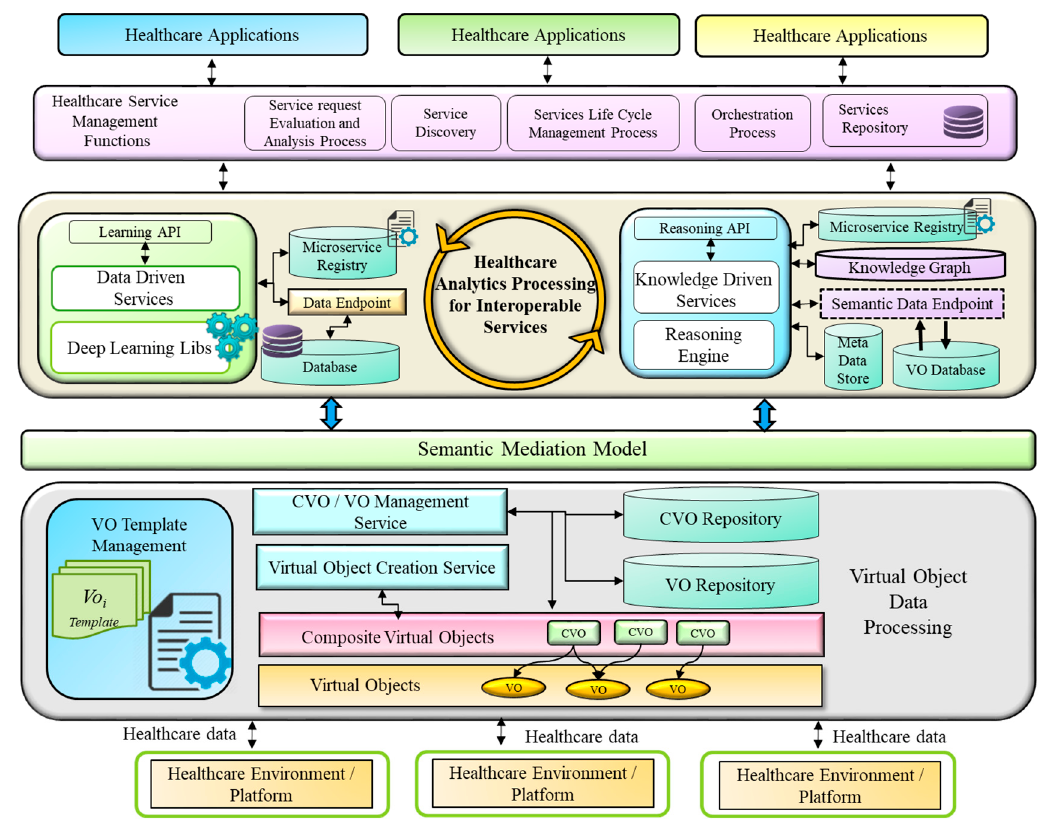
Figure 2. High level design of interoperable healthcare services with the Web of Objects (WoO) model.